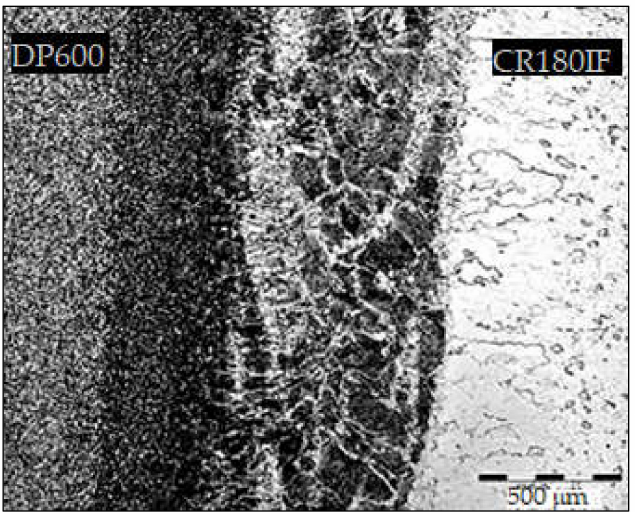
Figure 5. The microstructure of welded joint CR180IF and